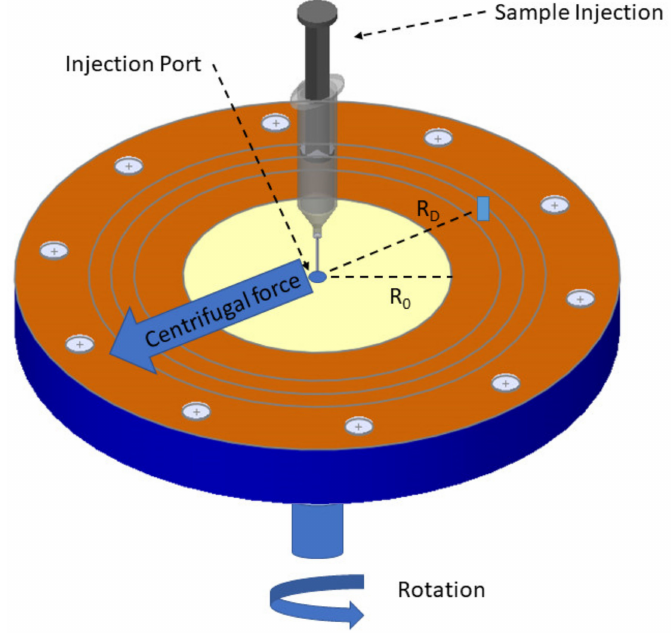
Figure 11. Schematic diagram of differential centrifugal